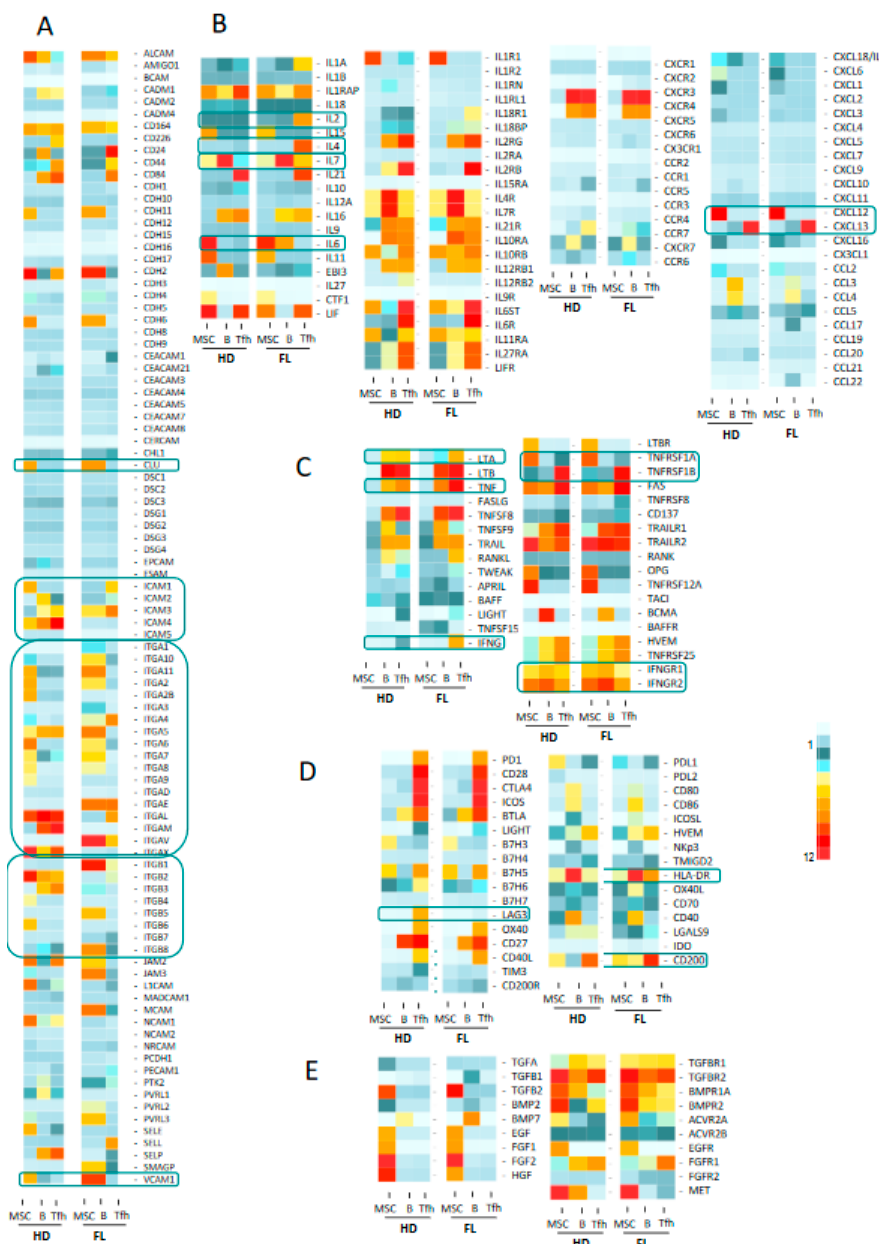
Figure 3. Heat map analysis of the expression of molecules and their relevant receptors by FL B cells, Tfh and mesenchymal stromal cells (MSC) in FL context compared to healthy donors (HD): adhesion molecules ( A ), cytokines and chemokines ( B ), TNF superfamily factors ( C ), immune checkpoints and co-stimulatory or inhibitory molecules ( D ) and TGF superfamily and other growth factors ( E ). Selected molecules correspond to non-redundant set of genes compiled from Refseq, NCBI and Genecard datasets. Data are means of normalized Affymetrix intensities for each molecule in each group.